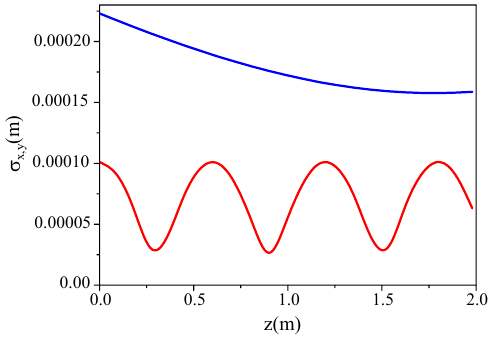
Figure 4. Electron sizes σ x , (blue curve) and σ y (red curve) (m) along the undulator coordinate z(m) for λ = 15.2 µ m, emittance (cid:101) = 1 mm mrad, loss =